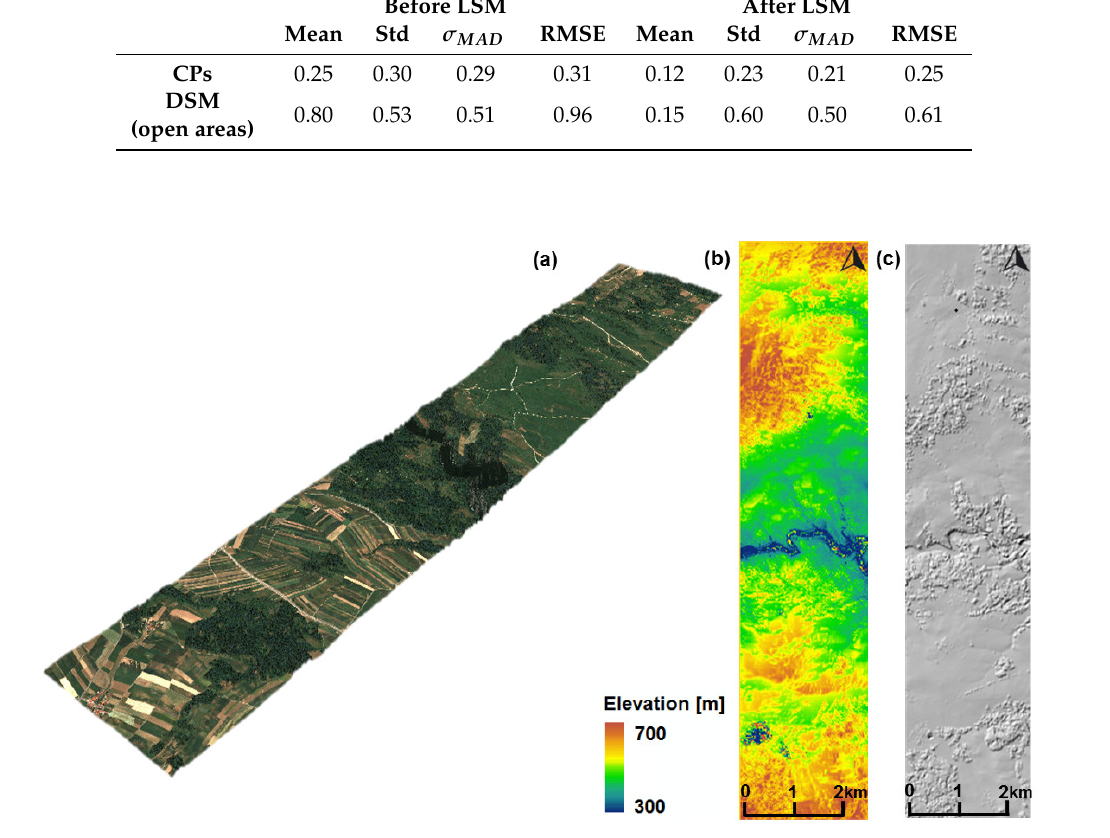
Figure A1. Image matching and 3D reconstruction results for the study area selected for the semantic segmentation: ( a ) 3D point cloud; ( b ) color coded view of the DSM; and ( c ) shaded view of the reconstructed